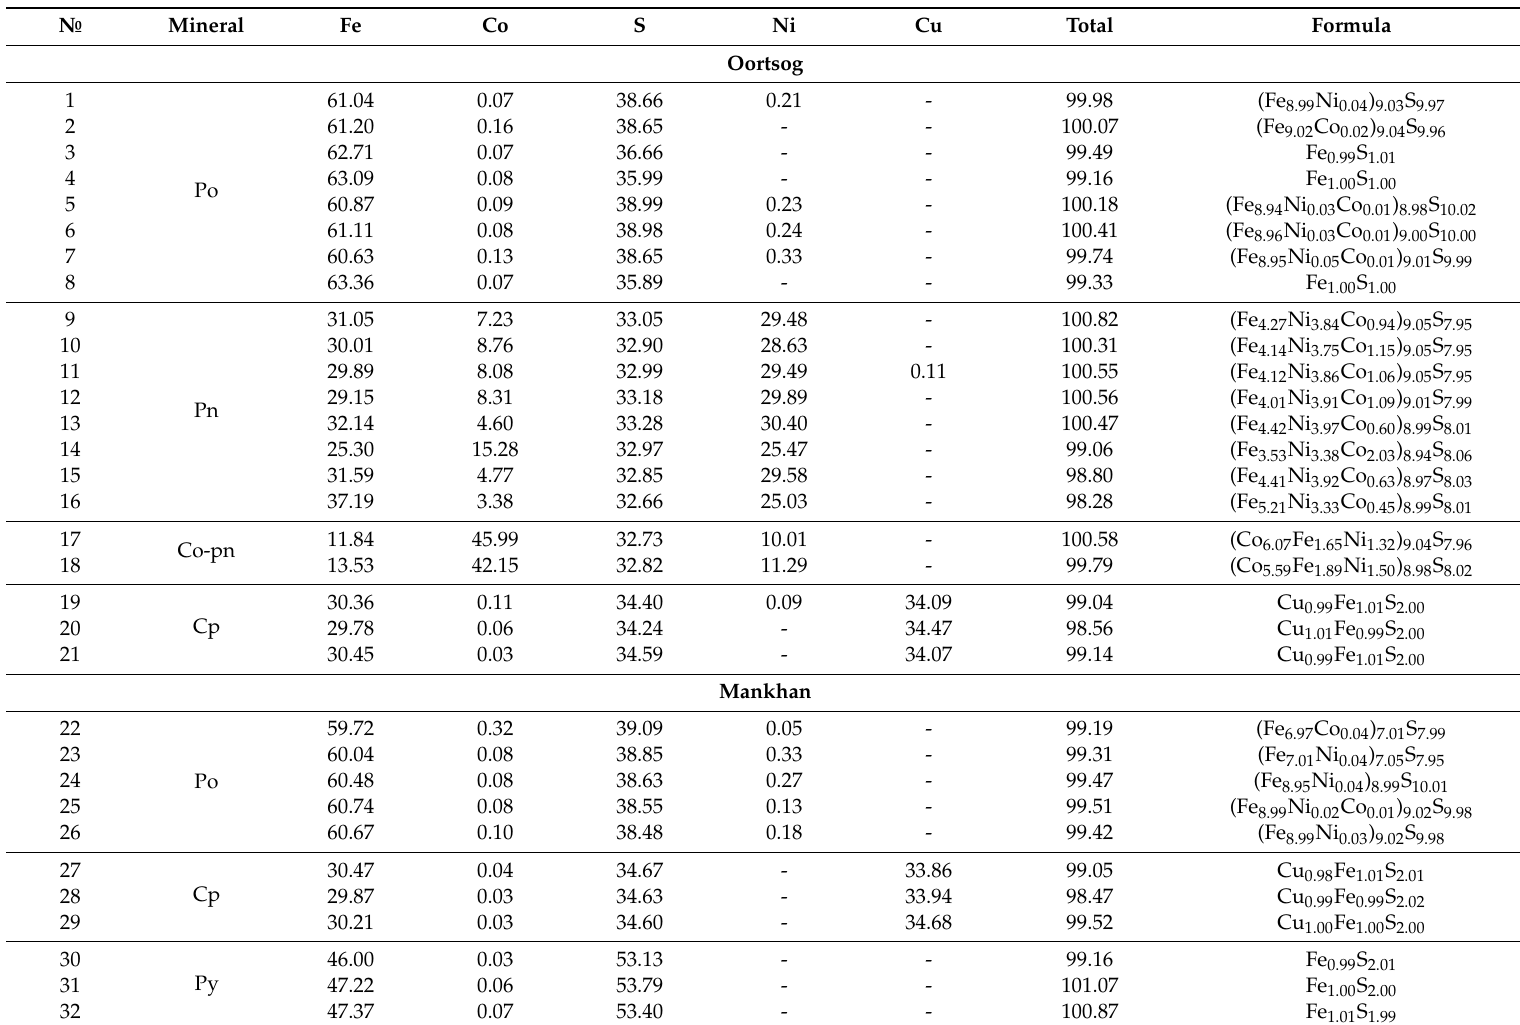
Table 2. Composition of sulfides (wt%) in mafic-ultramafic massifs of the Khangai upland shown in Figure